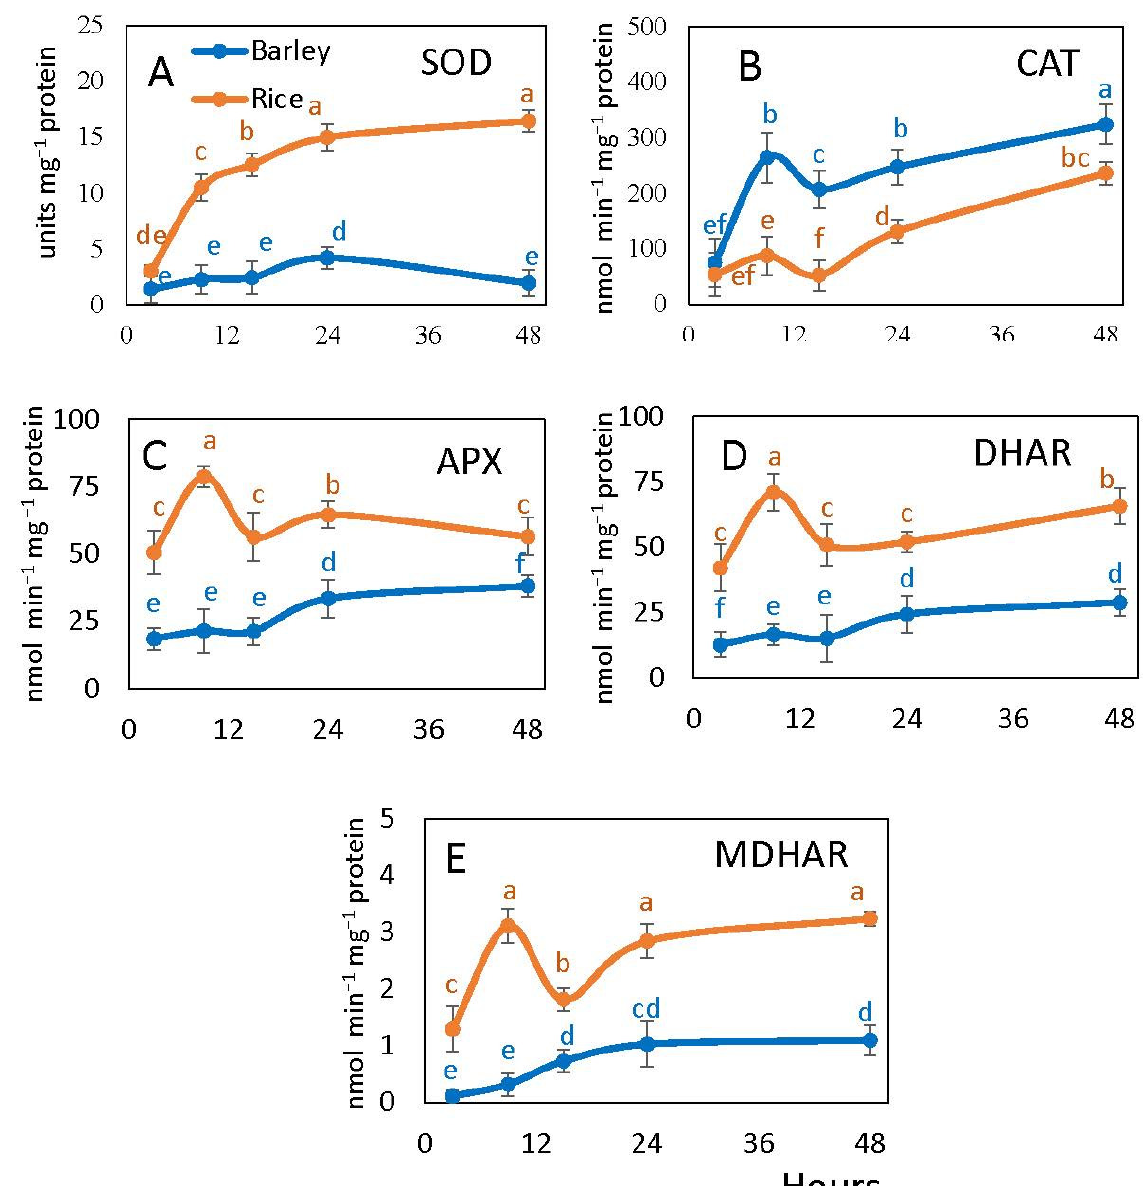
Figure 5. Embryonic antioxidant enzyme activities of barley and rice seeds following imbibition: superoxide dismutase (SOD) ( A ), catalase (CAT) ( B ), ascorbate peroxidase (APX) ( C ), dehydroascorbate reductase (DHAR) ( D ), monodehy- droascorbate reductase (MDHAR) ( E ). Vertical bars represent standard deviations ( n = 3). Different letters indicate significant differences between the two species and the time points at p < 0.05, (one-way ANOVA test, Tukey comparison).